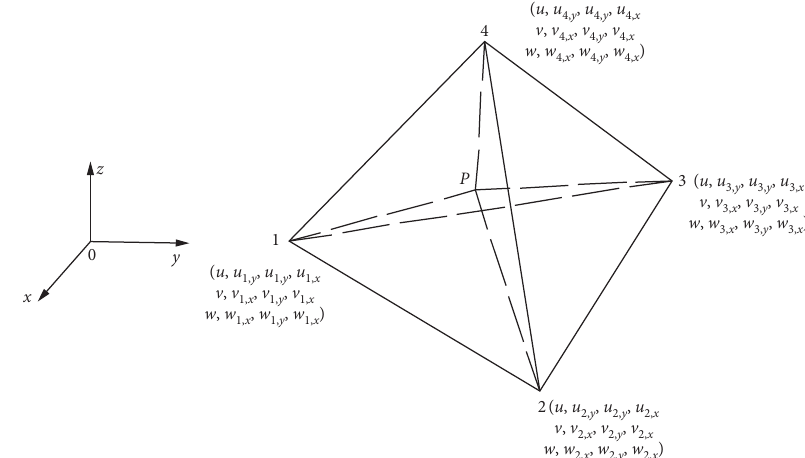
Figure 5: Tetrahedral elements with C 1 order